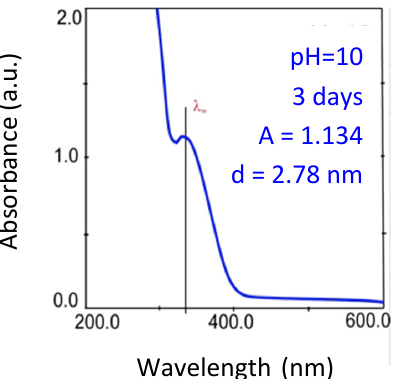
Figure 1. Absorption spectrum of the cadmium sulphide-Bovine Serum Albumin (BSA) quantum dots (CdS BSA QDs) 3 days after the synthesis process: pH = 10; Temperature: 22 °C (“A” is absorbance and “d” is diameter).